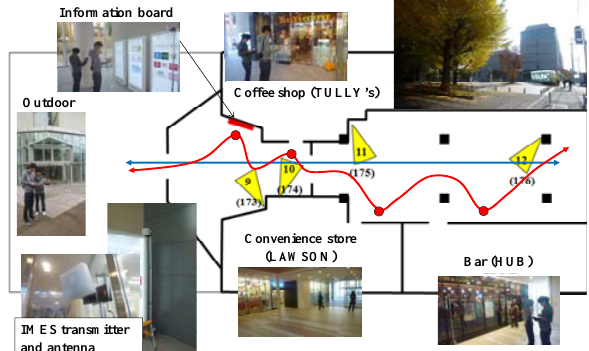
Figure 4. Data acquisition route and IMES antennae